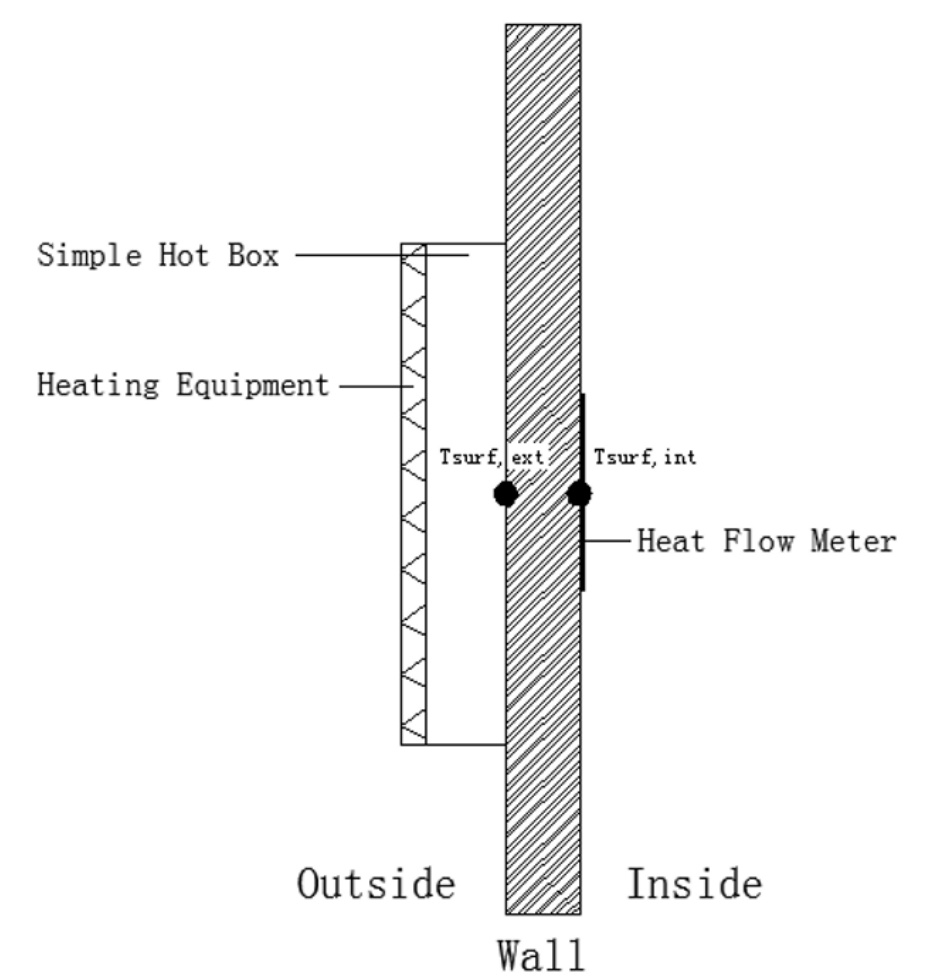
Figure 3. Schematic View of the Simple Hot Box Setup in Summer Condition.